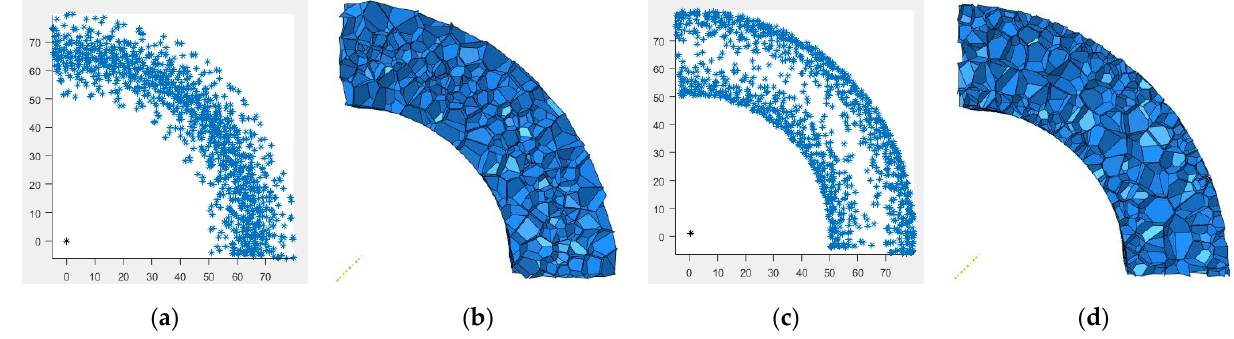
Figure 4. The second polar coordinate 3D-Voronoi modeling process. ( a ) Schematic diagram of MH-type nucleation point, ( b ) MH-type foam model, ( c ) schematic diagram of MS-type nucleation point, and ( d ) MS-type foam model.